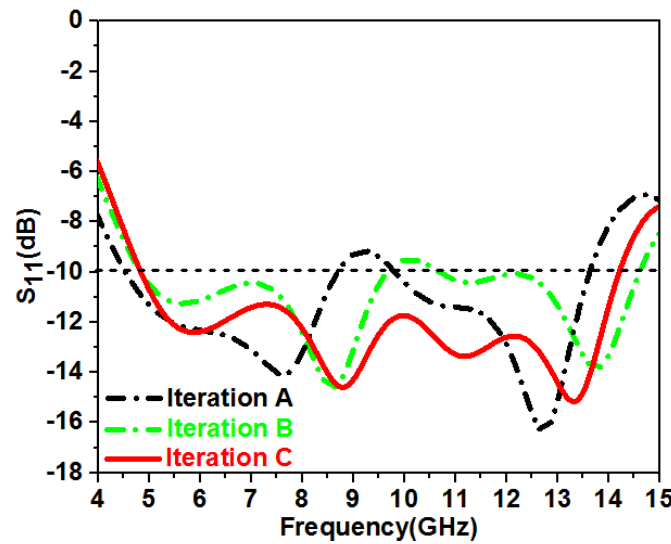
Figure 7. S 11 features of ground plane truncations.